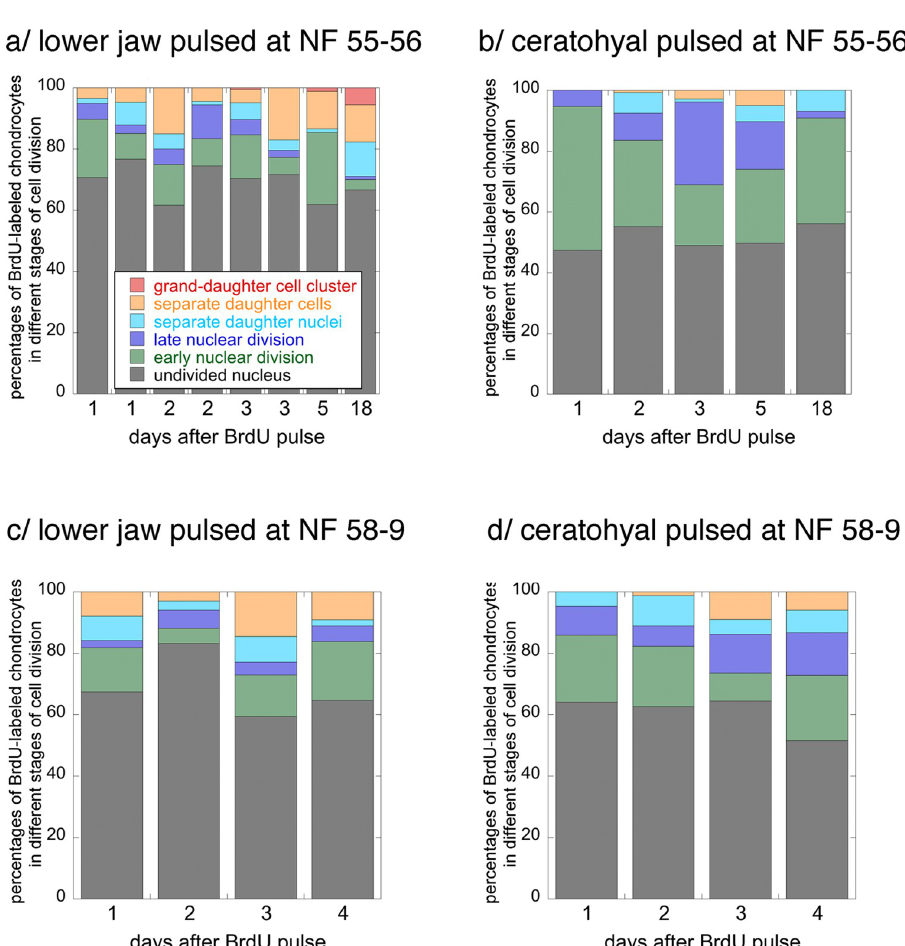
Fig 6. Percentages of lower jaw and ceratohyal chondrocytes progressing through mitosis in the lower jaw and ceratohyal at NF 55–6 and 58–9. Each column represents data collected from phase photos of cartilage from a single specimen following a 2-hour pulse of BrdU; see Materials and Methods and Fig 2A for descriptions and images of the six stages of cell division. The trajectories for cell shape, cell orientation, and percent matrix are derived from the same photos used to measure cell size (Fig 8A–8C and S3 Table). Cell shape is the ratio of a cell’s long axis to its short axis. Though the mean values are generally between 1.6 and 2, they fluctuate with stage for all three cartilages (Fig 8A). Whereas the lower jaw and ceratohyal mean values appear to decrease with stage and their fluctuations to increase in amplitude, the branchial arch values do the opposite. The mean angle of cell long axes relative to cartilage long axes is generally above 45˚ for all three cartilages. It is within 60-75˚ at early larval stages, and appears to decrease until metamorphosis when point it levels off. The percent matrix tra- jectories differ dramatically between the lower jaw and the other two cartilages (Fig 8C). The lower jaw trajectory is roughly opposite to its cell size trajectory (Fig 7A), with values starting low and increasingly steeply from NF 53 to 63. Ceratobranchial and ceratohyal values stay gen- erally below 20% until NF 60 when ceratobranchial measurements were discontinued, and NF 64–66 when ceratohyal values increase rapidly. Percentages of chondrocytes showing DAPI- stained nuclear fragmentation differ dramatically between lower jaw and ceratohyal, staying � 1% in the former and reaching 21% in the latter (Fig 8D). Ceratohyal values tend to